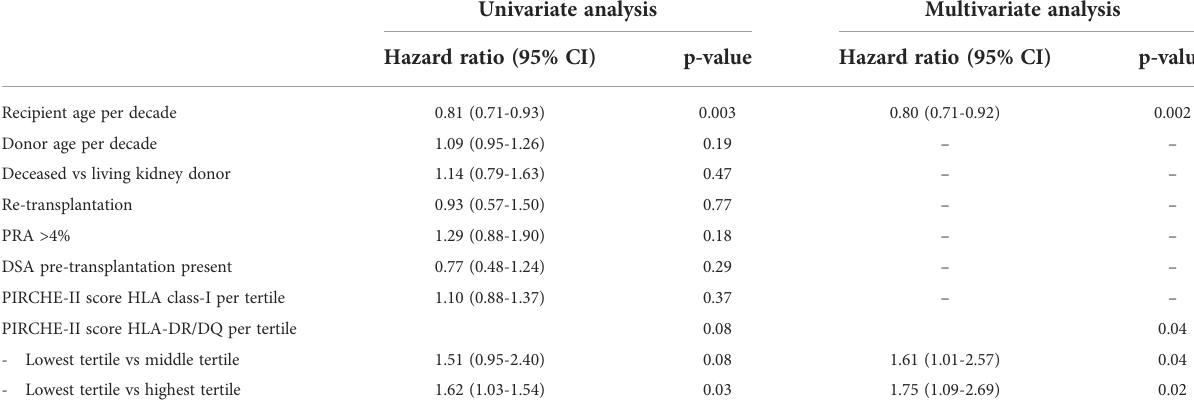
TABLE 2 Uni- and multivariate Cox proportional hazard analysis for T-cell mediated rejection borderline and Banff grade 1.